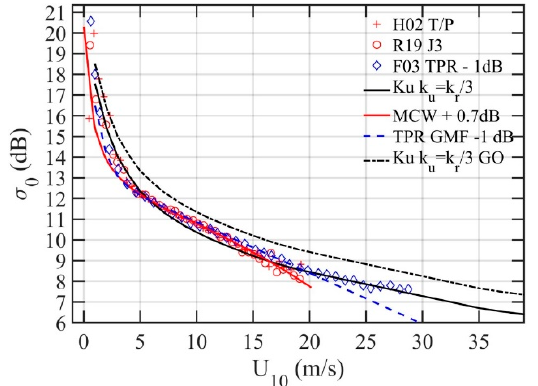
Figure 11. Ku band altimeter NRCS from T/P, J3, and TPR missions (normal incidence) and com- parison with NRCS computations using the H18 LPMSS integrated to k r /3 (black solid line). The MCW and TPR GMFs (with adjustment) are shown with red solid and blue dashed lines; more detail is given in the text.